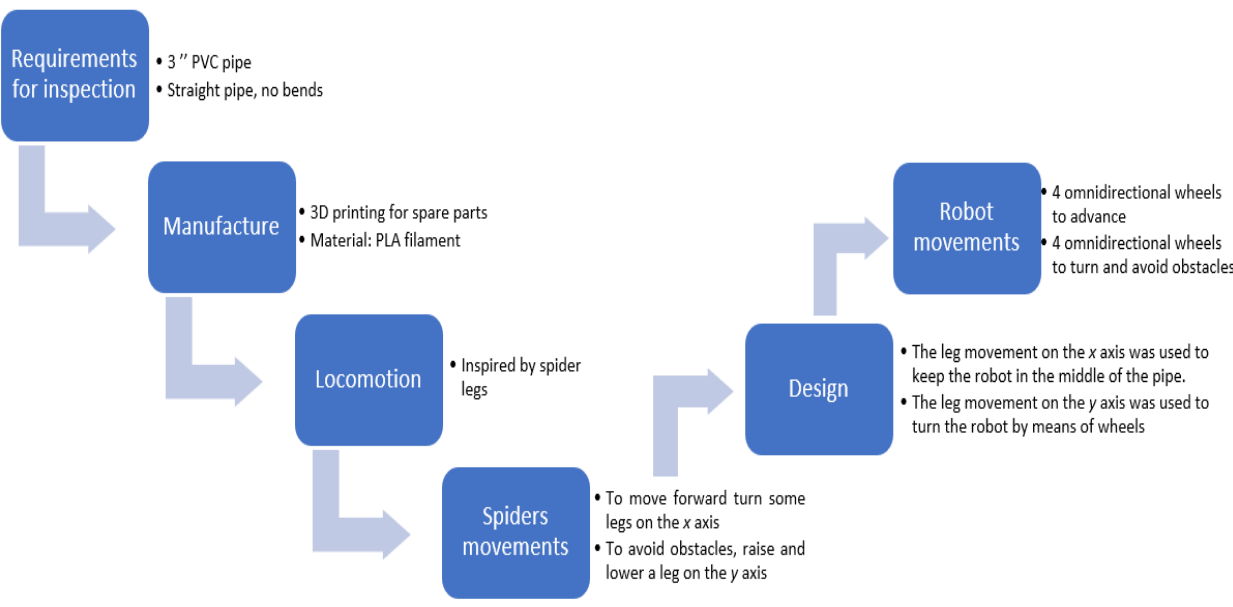
Figure 1. Design concepts for mobile robots as inspired by spider structure. Pipes space reduces the possibility of free robot movements. Therefore, the robot’s de- sign is based on hybrid locomotion, where they have legs and wheels; the legs influence the robot to stay in the middle of the pipe while the wheels help the movement. Subdrainage pipes accumulate dust in their lower part, so four lateral legs with springs attached to the body can be conveniently implemented. Furthermore, the legs can be actuated with a pressure that is exerted by springs. Figure 2 shows a proposed design referring to spider characteristics in which the attached body links are lifted in the y -axis, while the entire body robot rotates on its axis. Each arrow represents the direction in which the spider’s legs and the wheels of the robot move. A robot needs these movements to avoid